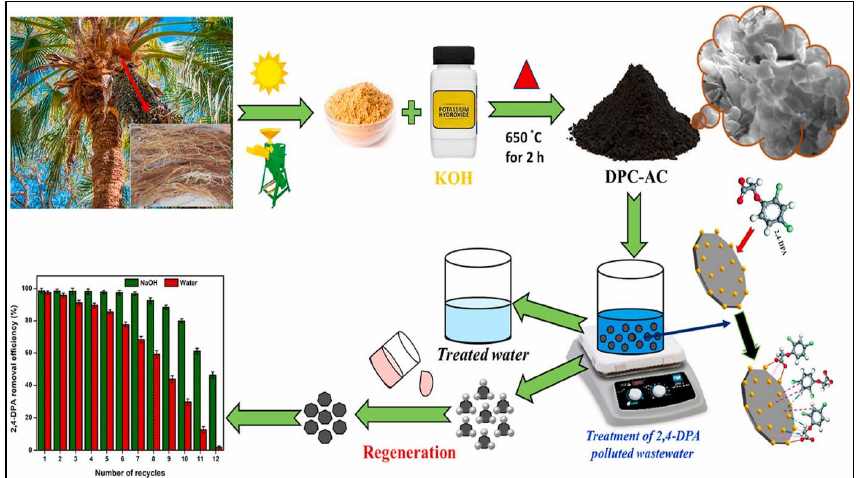
Figure 8. Schematic illustration of nano-activated carbon prepared from date-palm coir waste and its usage in toxic herbicide removal. Reprinted with permission from Ref. [123], 2021,